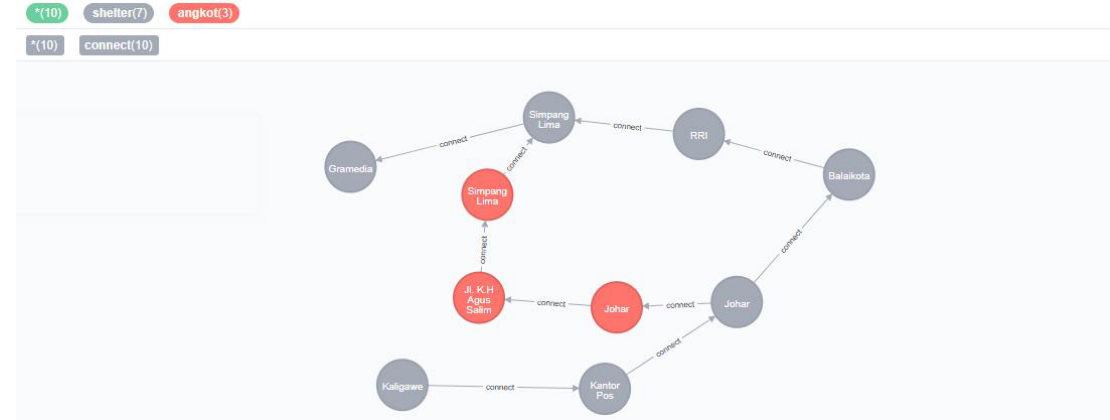
Fig. 8. Query result in Neo4j browser.